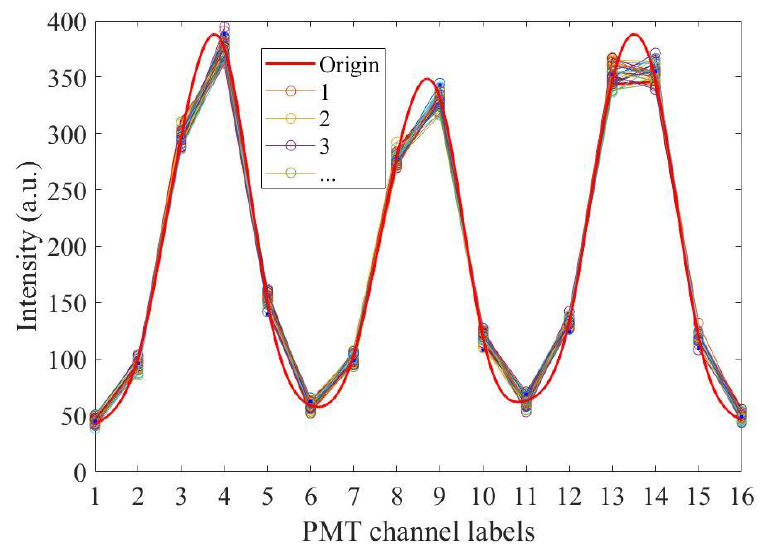
Figure 15. Simulated scattering spectrogram received by a 16-multichannel PMT under an SNR of 35.